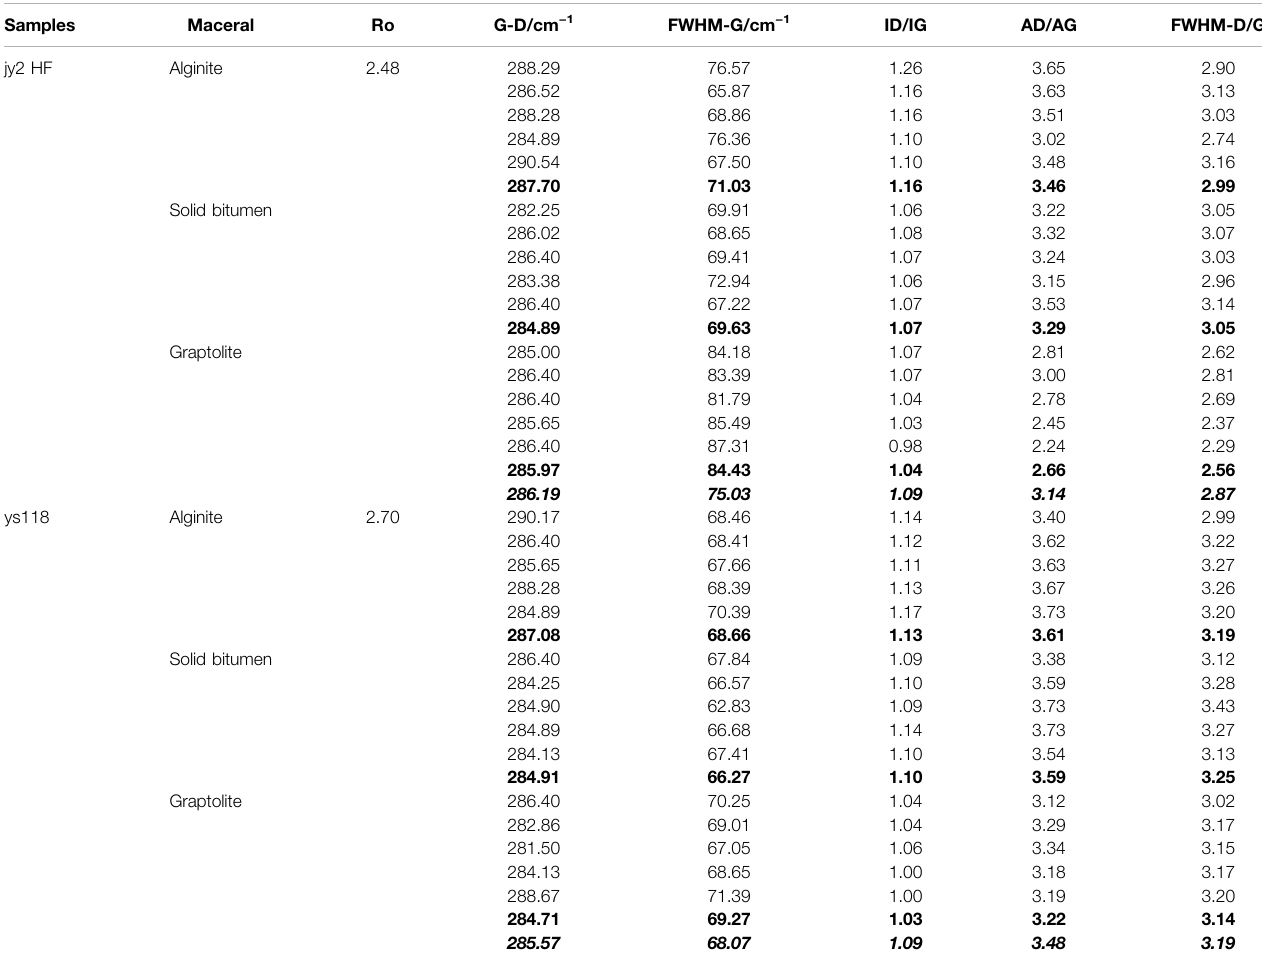
TABLE 2 | Raman structure parameters of three macerals for the two samples. Samples Maceral